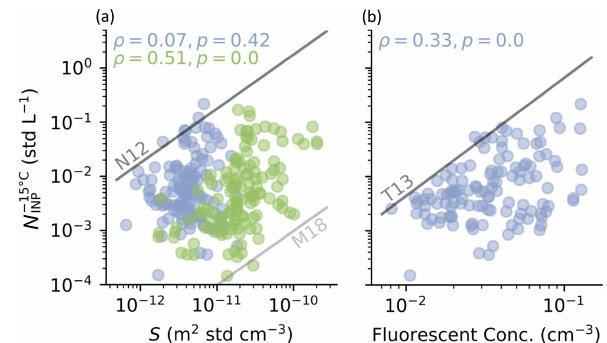
Figure 5. Observed INP concentration at a nucleation temperature ◦ C of − 15 ◦ C (N − 15 ) as a function of (a) the ambient aerosol sur- INP face area concentration ( S ) and (b) the ambient number concentra- tion of fluorescent particles during sampling in the autumn (violet) and spring (green) campaign. The green points are absent in (b) be- cause the fluorescence measurements were only conducted in the autumn campaign. The Spearman’s rank coefficient ( ρ ) and p value are given for each season in each plot (the correlation for both sea- sons combined is presented in Table S1 in the Supplement). Further indicated are predicted INP concentrations by Niemand et al. (2012) (N12), McCluskey et al. (2018) (M18), and Tobo et al. (2013)